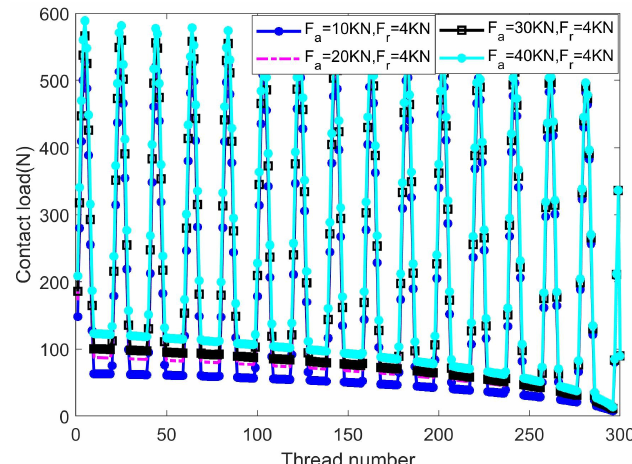
Figure 17. The effects of different axial loads in case